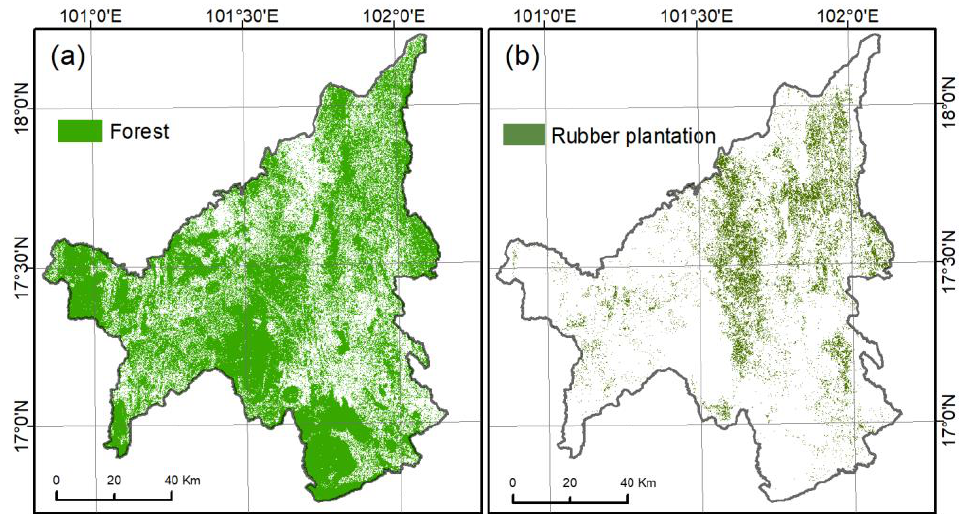
Figure 4. Distribution of the forest ( a ) and rubber plantations ( b ) of Loei Province in 2019.